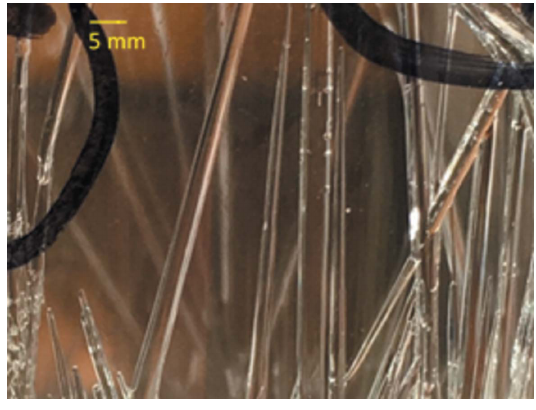
Figure 1 Rod-like crystals of the water–TMP complex as grown in the sealed